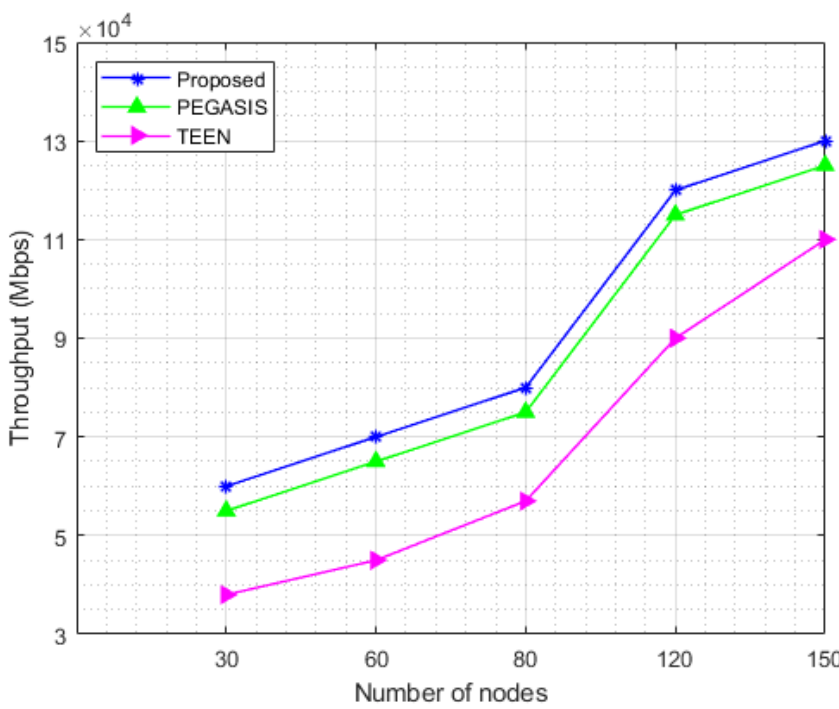
Figure 17. Number of nodes vs. throughput (150 nodes).